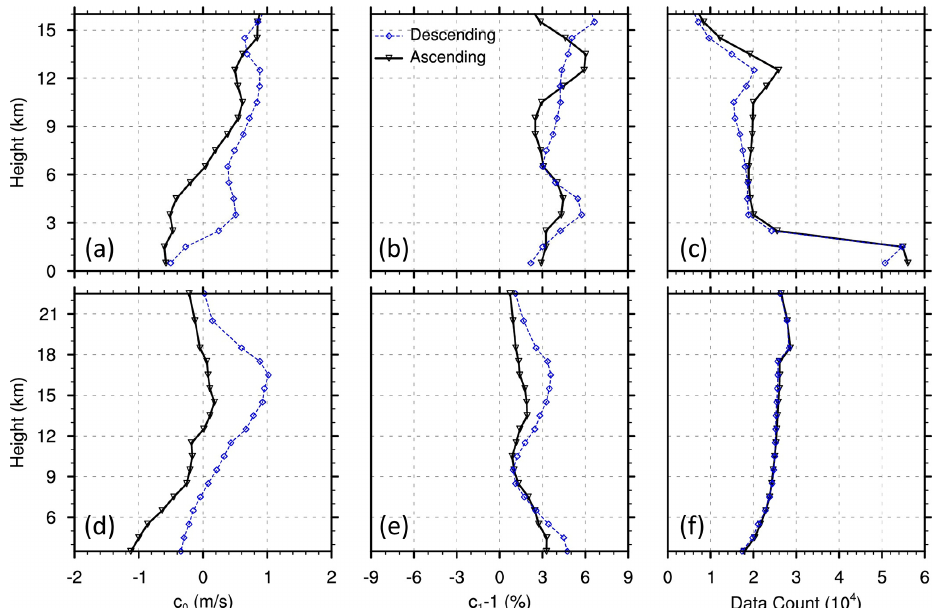
Figure 7. Vertical variations in TLS bias coefficients for Mie (a–c) , and Rayleigh (d–f) winds. Each point plotted represents a separate TLS analysis for all observations in each layer for all latitudes and for either ascending (black solid) or descending (blue dashed) orbits. The symbols are plotted at the average height of the observations in each layer.